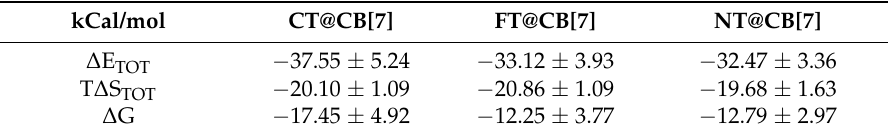
Table 2. Binding free energies (kCal/mol) of drug@CB[7] complexes by MM_GBSA method.